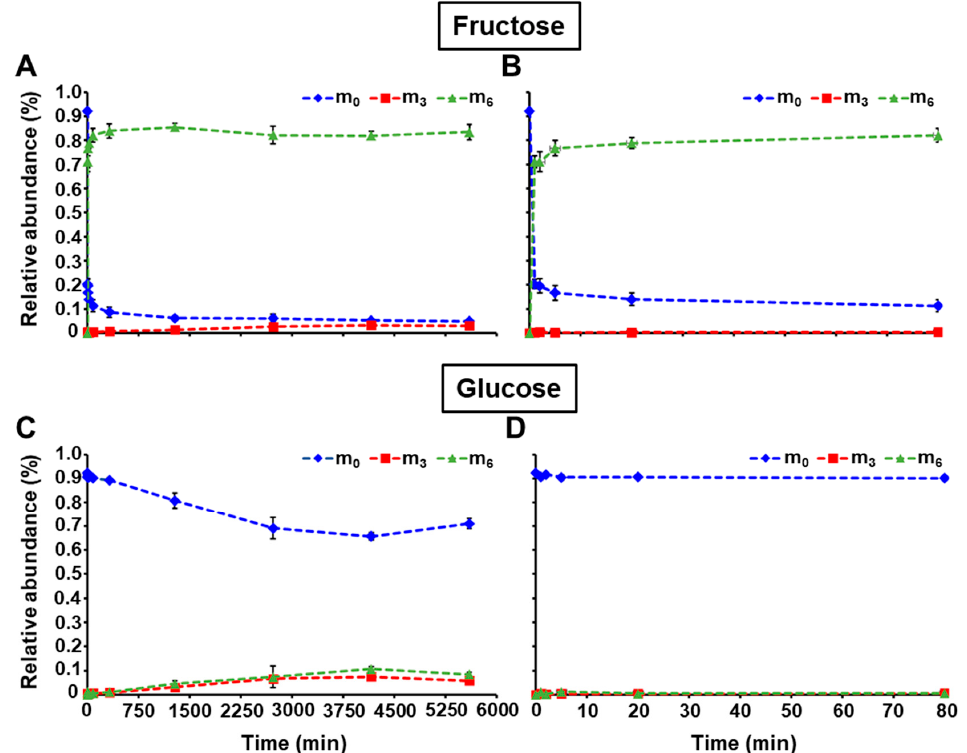
Figure 3. Relative abundance of isotopomers for intracellular fructose and glucose during pulse labeling with [U- 13 C]fructose. ( A , C ) show the relative abundance of mass isotopomers at all time points for fructose and glucose, respectively. ( B , D ) represent the relative abundance of mass isotopomers from 0 to 80 min for fructose and glucose, respectively. Intracellular glucose and fructose were extracted, and analyzed as described in the “Materials and Methods” section. Mass relative abundances (in %) were reported as the average ± SD ( n = 4 biological replicates). Mass isotopomers m 0 , m 3 , and m 6 are depicted as blue diamond, red square, and green triangle, respectively.